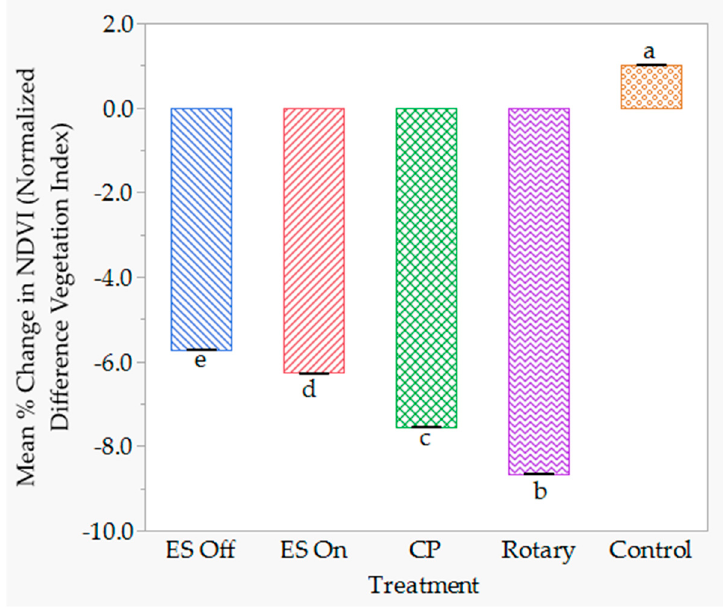
Figure 13. The percent change (±SEM) in NDVI values at 16 DAT obtained from aerial imagery. Means (±SEM) followed by the same lowercase letter are not significantly different ( p < 0.05) according to Tukey’s HSD test. The treatments described on the X -axis are electrostatically charged off (ES Off) and charged on (ES On) nozzles, the conventional hydraulic (CP) nozzle, and the rotary atomizer (Rotary) nozzle, compared with the Control.